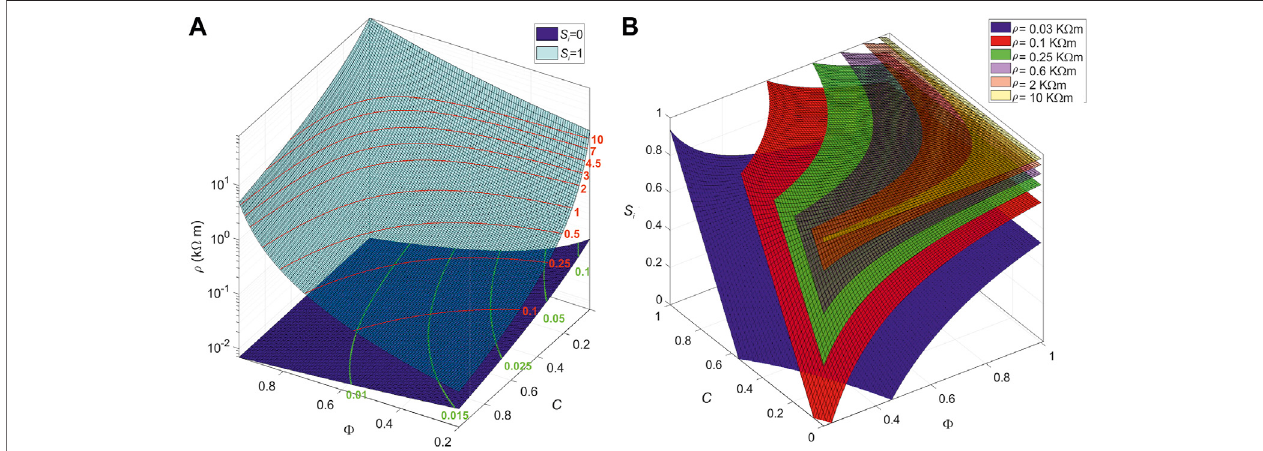
FIGURE 11 | Results of the CRIM petrophysical analysis. (A) resistivity of sediments fully saturated by water ( S i = 0, violet surface) and ice ( S i = 1, cyan surface), computed using Eq. 1 . Red and green isolines connect points of equal resistivity on the two surfaces. Cyan and violet surfaces correspond to permafrost and unfrozen ground,respectively. (B) icesaturation S i computedusing Eq.2 fordifferentsedimentresistivity.ComputationperformedbyadoptingtheMATLAB ™ softwarepackage.